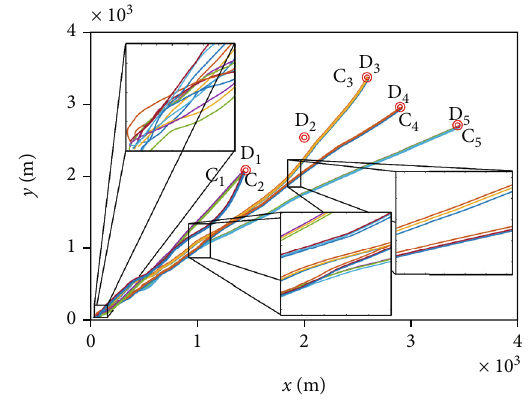
Figure 7: A cluster motion scenario.